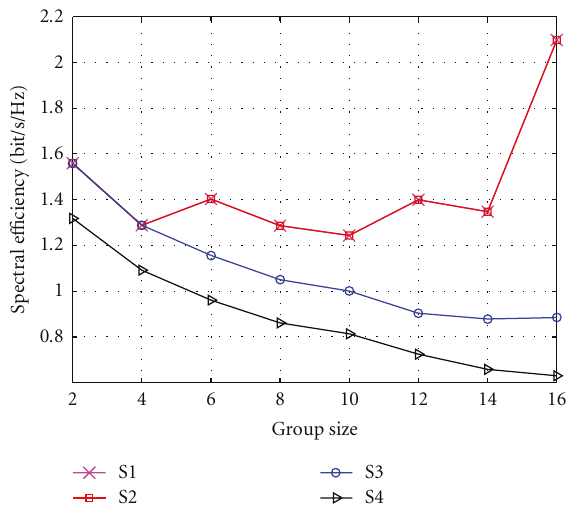
Figure 4: Packet error ratio of the first transmission.